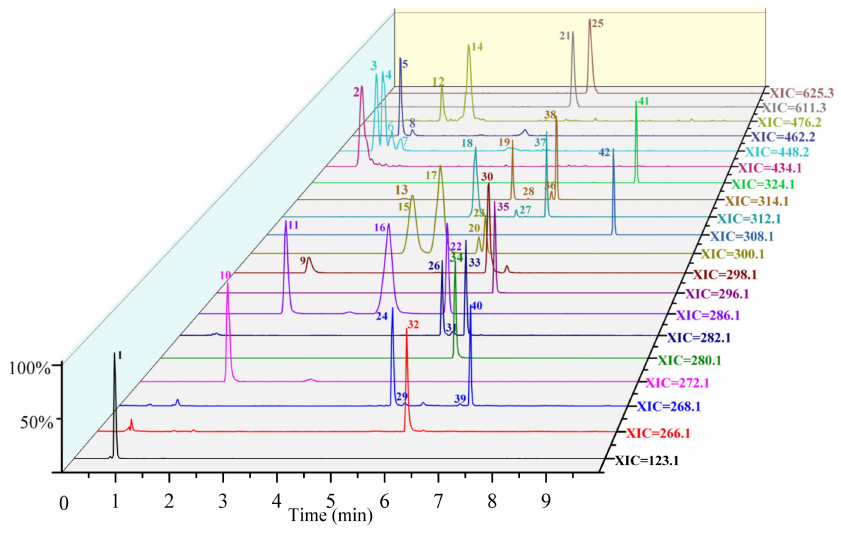
Figure 4. The extracted ion chromatograms of 42 alkaloids in lotus seed epicarp.